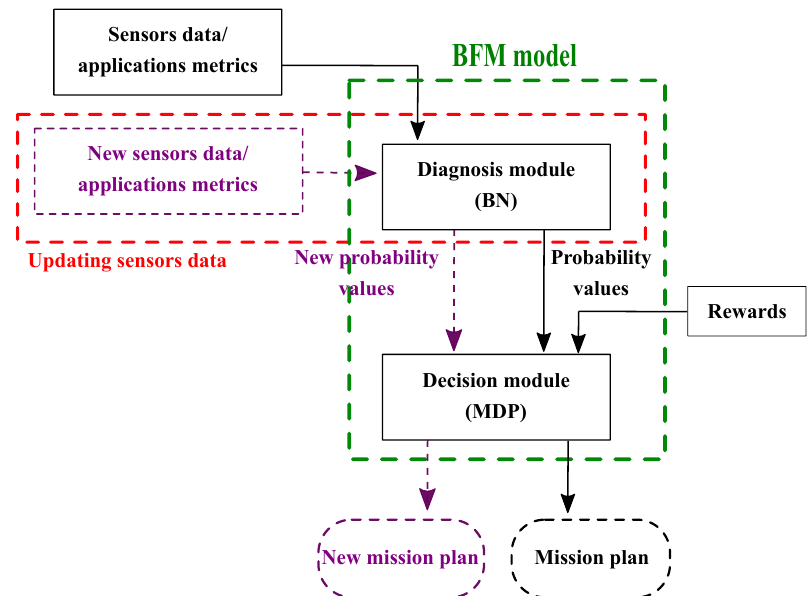
Figure 18. The execution of the embedded BFM